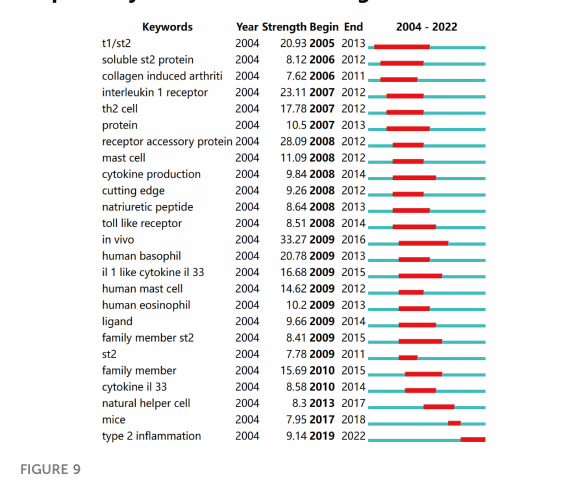
FIGURE 9 The top 25 keywords with the strongest citation bursts.